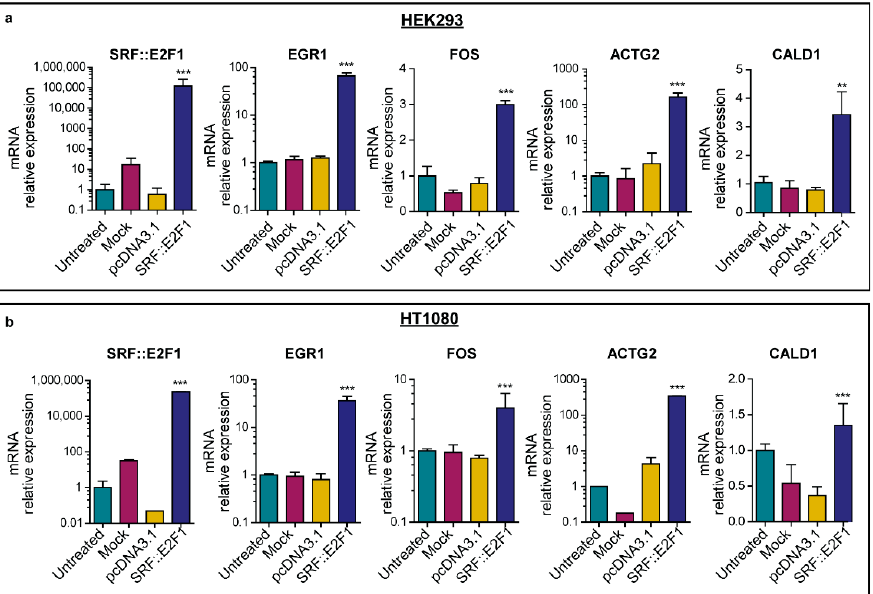
Figure 4. SRF::E2F1 expression in transfected cell lines. mRNA relative expression of SRF::E2F1, EGR1, FOS, ACTG2 and CALD1 , target genes of SRF , in HEK293 ( a ) and HT1080 ( b ) cell lines, 48 h after transfection. Fold changes were evaluated in comparison to untreated samples. GAPDH was used as housekeeping gene. P value was estimated against pcDNA3.1 by a one-way ANOVA (** p < 0.01; *** p < 0.001).